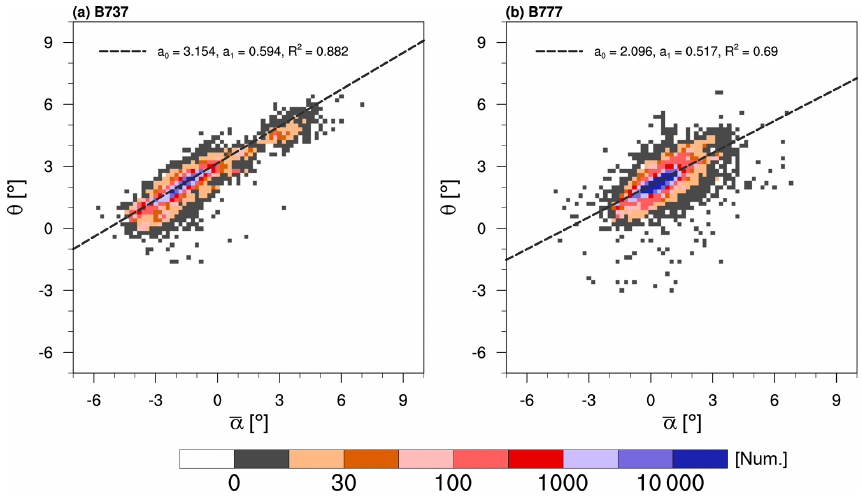
Figure 2. Scatter density plots (circle) of the measured angle of attack ( α) and pitch angle ( θ) , along with the least-squares linear regression fits (dashed line), for the (a) B737 and (b) B777. The least-squares intercept, slope, and degree of goodness of fit are written as a 0 , a 1 , and R 2 , respectively.